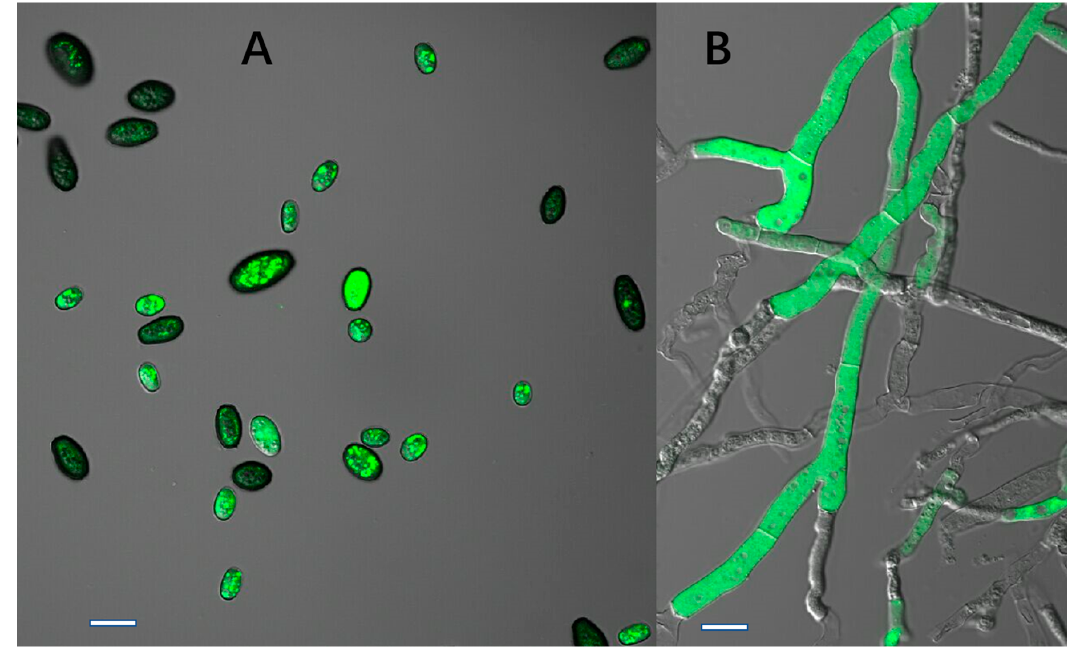
Figure 6. The isolated transformants exhibited strong green fluorescence in hypha and conidia. Bars: ( A,B ) = 10 μ m.